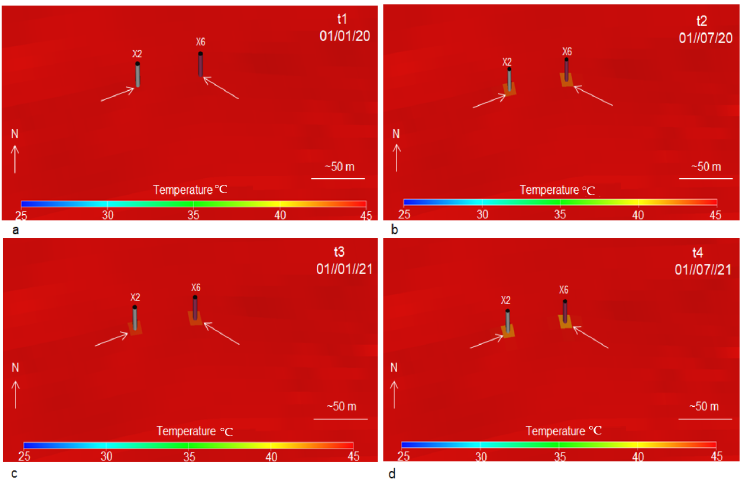
Figure 13. Temperature changes around wells X2 and X6 by injecting colder foreign gas at different time steps (t1, t2, t3, and t4). Time steps t1, t2, t3, and t4 correspond to 1 January 2020, 1 July 2020, 1 January 2021, and 1 July 2021, respectively. The arrows show the exact location of significant temperature differences during injection/production phases. The colour scale is in ◦ C, whereas the arrows with N indicate a northward direction. ( a ) is temperature at time t1; ( b ) is temperature at time t2; ( c ) is temperature at time t3; ( d ) is temperature at time